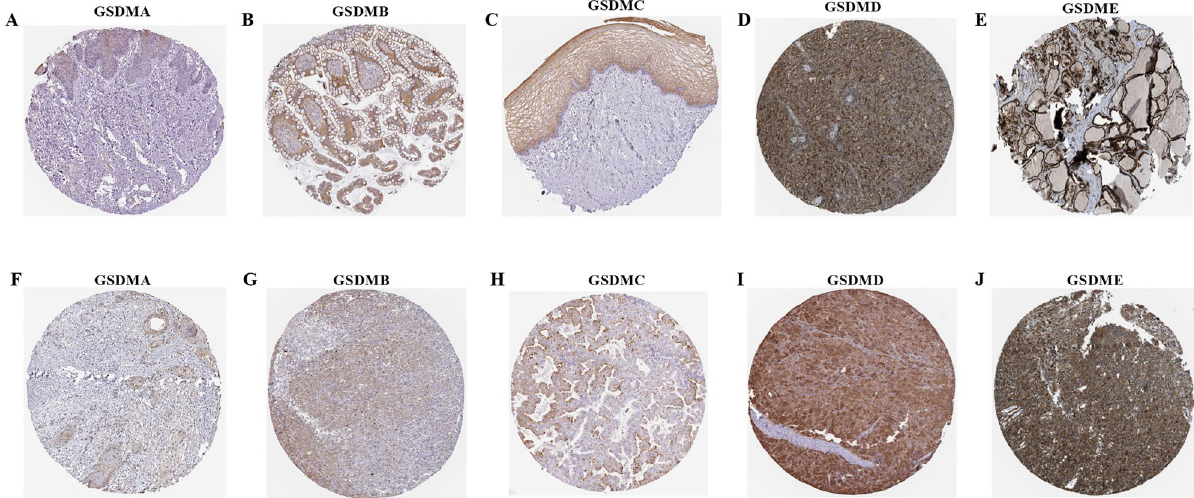
Figure 4. Representative IHC images of gasdermin family genes high expression in normal and tumor tissues. GSDMA expression in skin ( A ); GSDMB expression in small intestine ( B ); GSDMC expression in vagina ( C ); GSDMD expression in spleen ( D ); GSDME expression in thyroid gland ( E ); GSDMA expression in head and neck squamous cell carcinoma ( F ); GSDMB expression in stomach adenocarcinoma ( G ); GSDMC expression in lung squamous cell carcinoma ( H ); GSDMD expression in liver hepatocellular carcinoma ( I ); GSDME expression in glioma ( J ).